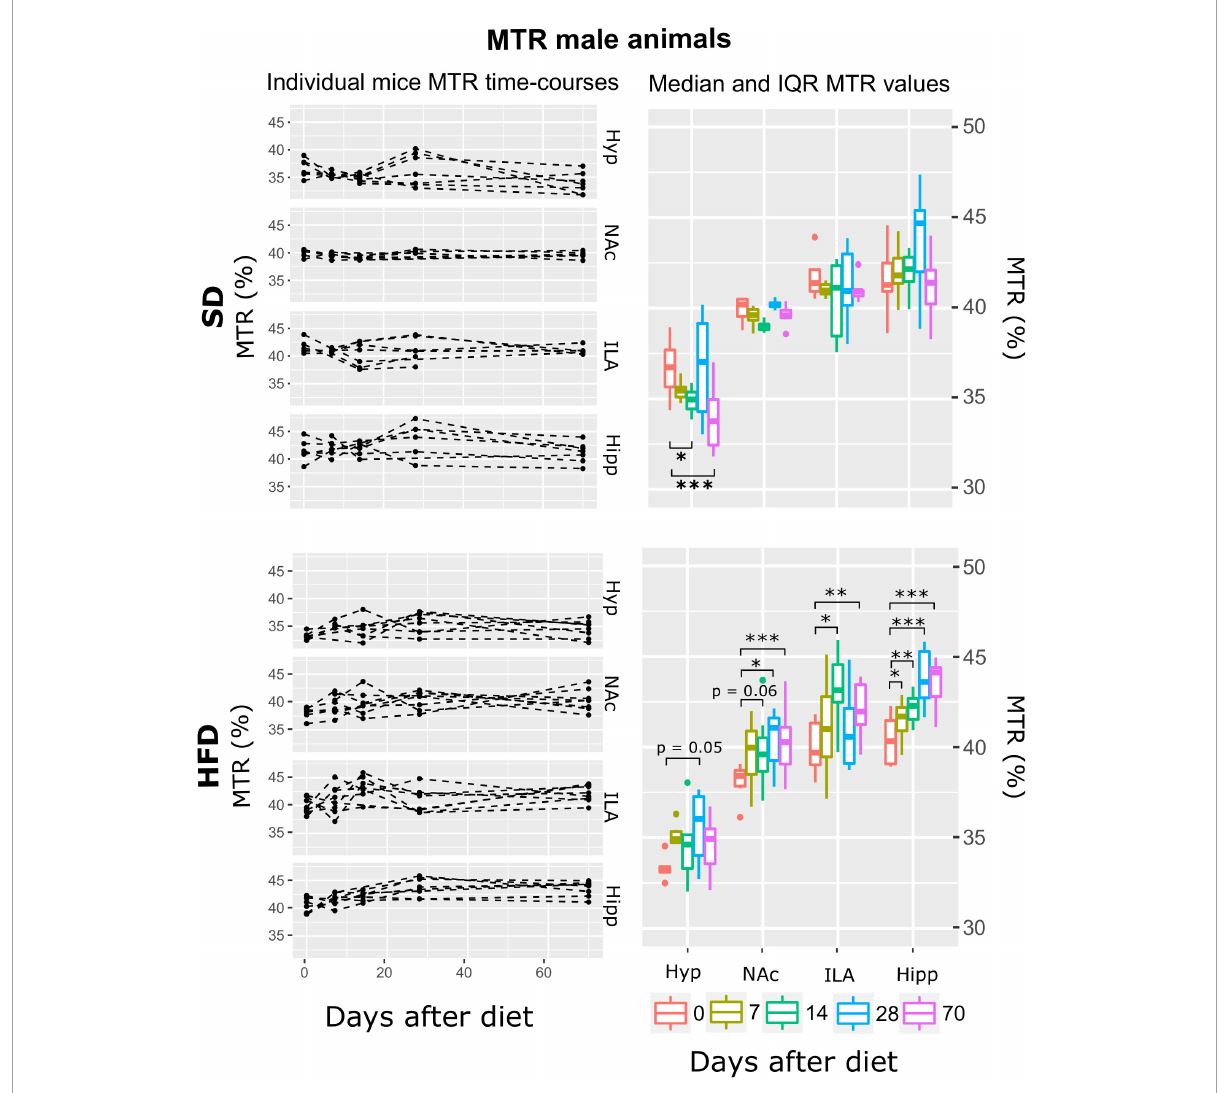
FIGURE3 MTR changes on male mice during HFD or SD consumption. MTR evolution on SD-fed (top panels) or HFD (bottom panels) male mice in the four cerebral regions investigated: hypothalamus (Hyp), nucleus accumbens (NAc), ipsilateral area (ILA) and hippocampus (Hipp) at all time points measured. Left panels depict the individual MTR regional values at each time point, with dashed lines connecting the neighboring points. Right boards illustrate box plots of MTR vs. time-point measurements for the 4 regions assessed, with each color representing the different time-points evaluated, expressed as days after diet diversification. Note how MTR increases with time only on animals under HFD (* p < 0.05, ** p < 0.01, *** p <